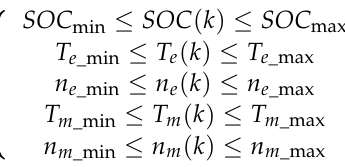
( b ) Figure 16. Slip ratio prediction results. ( a ) UDDS; ( b ) HWFET. (single pavement). Similar to the speed prediction, the RMSE is used to describe the prediction accuracy. When the prediction time is 5 s, the RMSE under UDDS and HWFET is 0.091 and 0.07, respectively. Due to the fact that the BPNN can achieve a good prediction accuracy, the BP network is utilized to predict the slip rate. 4. Predictive Energy Management Based on Predictive Trip Information 4.1. Predictive Energy Management Strategy Based on Predictive Trip Information With a fixed vehicle configuration, simulations with different 𝑆𝑂𝐶 ranges are per- formed. By analyzing the change trend of the optimal 𝑆𝑂𝐶 trajectory, we found that the